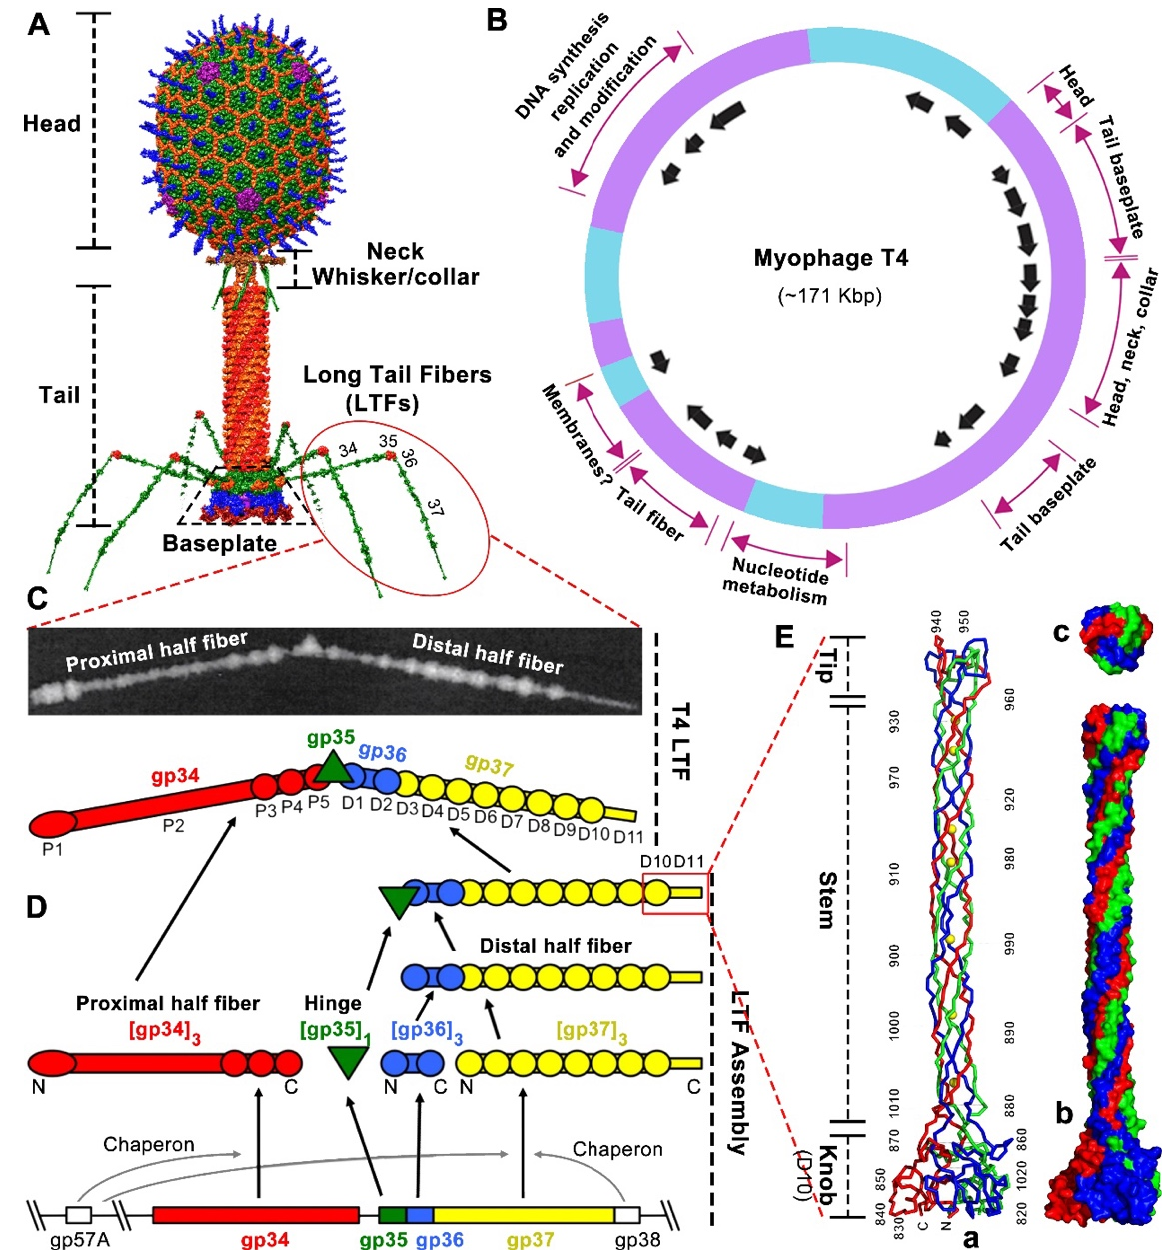
Figure 1. T4 phage architecture and the structure and assembly of long tail fibers. ( A ) T4 phage architecture [59]. ( B ) T4 genetic map showing gene clusters with related functions and origin and direction of transcripts (arrows) [60]. ( C ) The structure and schematic of T4 long tail fiber with seventeen mass domains observed by scanning transmission microscopy [54]. Reprinted with permission from Elsevier. ( D ) The assembly of T4 long tail fiber [8]. ( E ) The structure of the T4 long tail fiber “needle” (D10 and D11) responsible for host receptor recognition [57]. (a) Ribbon structure of the trimeric “needle” consisting of knob, stem, and tip. The N and C termini and every 10th residue of one chain are labeled. (b,c) Surface structure of the trimeric “needle” seen from the side (b) and top (c).